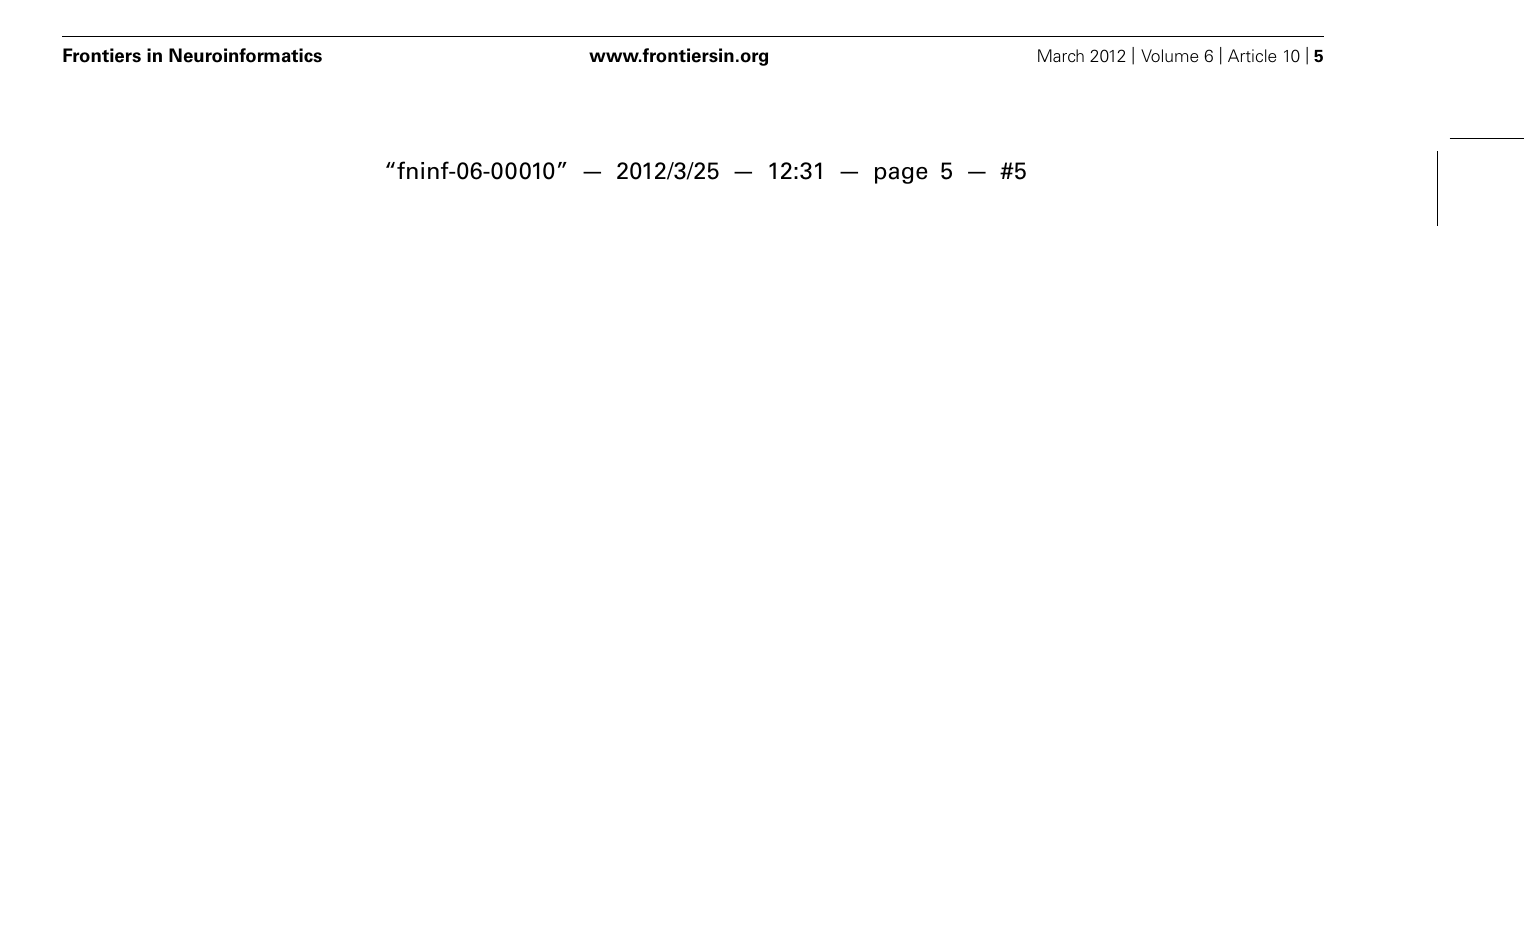
FIGURE 2 |The structural (sMRI) components (red) and corresponding rs-fMRI components (blue). The spatial correlation between component pairs is indicated adjacent to the functional component number. Both sMRI and fMRI aggregate components were converted to z -scores and thresholded at Z > 2. Structural components are displayed at the slices with